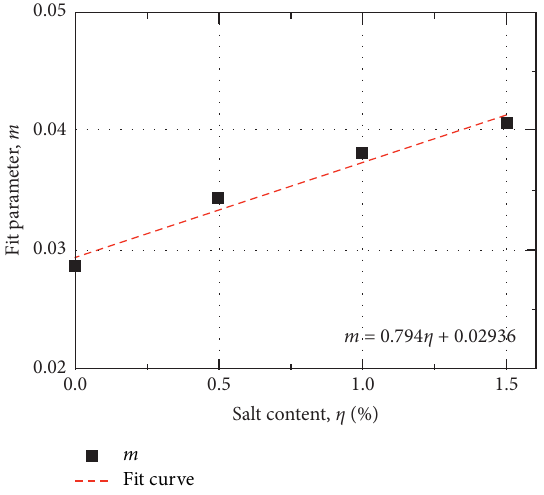
Figure 11: Fit result for parameter m